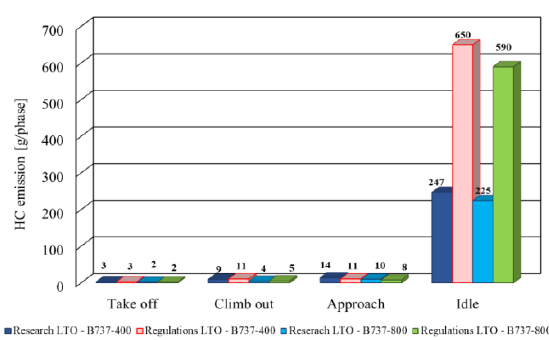
Fig. 8. HC emission for B737-400 and B737-800 in regulations and re- search LTO cycle in each phase